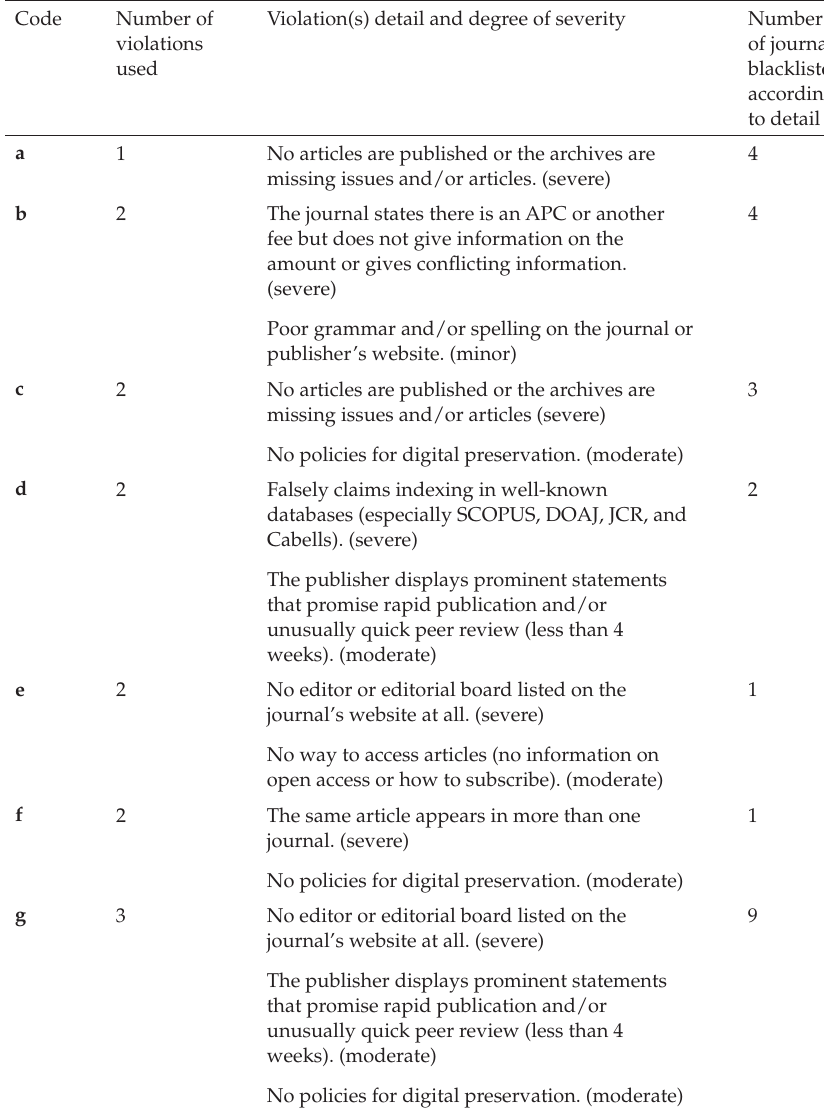
Table 2: Number and detail of violation combinations for journals we observed included in Cabell’s blacklist on the basis of 1 to 3